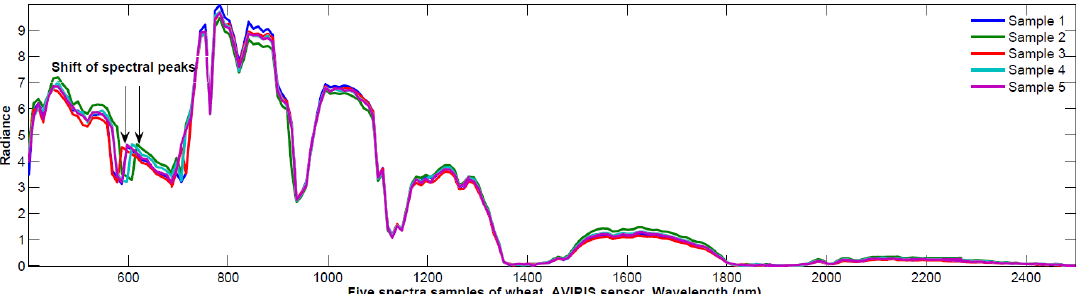
Figure 7. Illustration of spectral peaks’ shift, wheat samples in AVIRIS 92AV3C